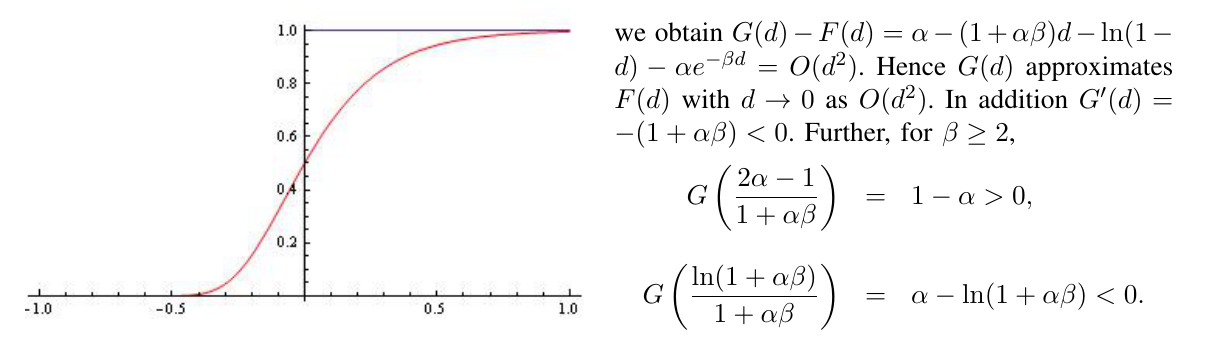
Fig. 5. The Gompertz function with α = ln 2 and β = 5 ; H-distance d = 0 . 212765 .